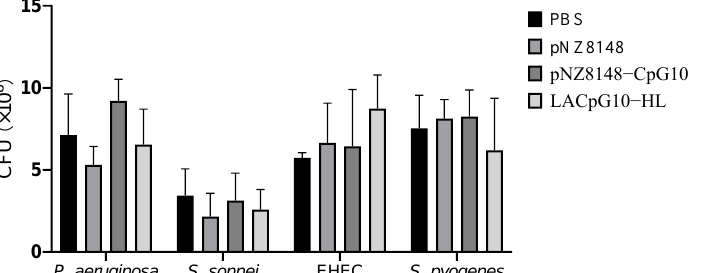
Figure 3. LACpG10-HL possessed no direct antibacterial effects. After 24 h co-culturing, the four